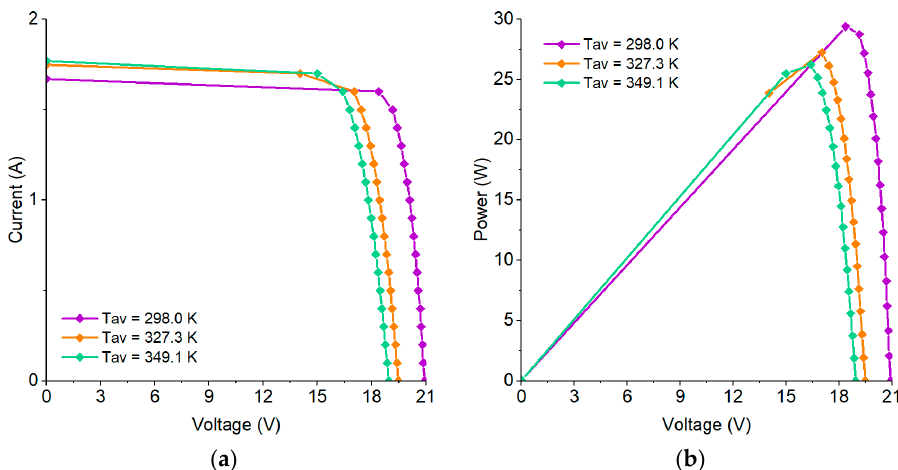
Figure 7. Variations in the performance of the 50 Wp PV panel depend on its temperature (without any cooling system): I-V characteristic ( a ) and P-V characteristic ( b ).